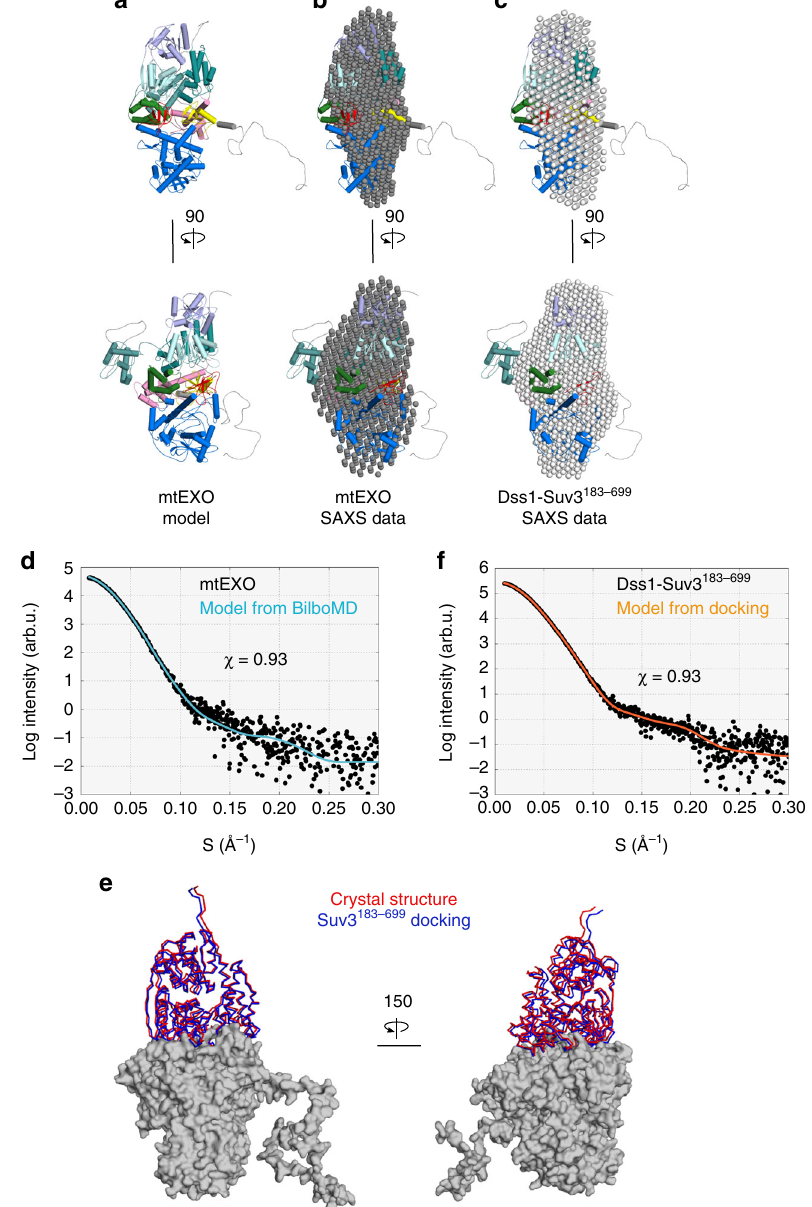
Fig. 3 Small-angle X-ray scattering experiments for Cg -mtEXO. a Model of full-length ( fl ) Cg- mtEXO calculated using Bilbo. b Model of fl - Cg- mtEXO with superimposed three-dimensional reconstruction from SAXS data for fl - Cg -mtEXO (gray spheres). c Model of fl - Cg- mtEXO with superimposed three- dimensional reconstruction from SAXS data for Cg- Dss1-Suv3 183-699 (gray spheres). d Comparison of the computed X-ray scattering curve for fl - Cg - mtEXO model shown in a (cyan) with the scattering data collected for fl - Cg -mtEXO (black circles). e The best model obtained from docking Cg -Suv3 183-699 to Cg- Dss1 using FoxsDock 28 . Cg- Dss1 is shown in gray surface representation. The Suv3 subunit from the Cg- mtEXO crystal structure is shown as a red wire. The position of Cg- Suv3 in the best-scored model is shown as a blue wire. f Comparison of the computed scattering curve for the model from docking shown in e (orange) with the SAXS data for Cg- Dss1-Suv3 183 – 699 (black protein-protected RNA length in the mtEXO channel would be 6 nt RNA fragment is also bound in the structure of human SUV3 ~18 nt. with the fi rst nucleotide exposed to the solvent 7 . The RNA is bound by residues from the helicase motifs: Ia (Lys234), Ib (Thr275) of the RecA1 domain and IV (Phe373 and Lys375), V (Thr424 and Asp425) of the RecA2 domain 7 . These motifs are conserved in Cg -Suv3 and we assume they will contact RNA in the same way. Upon superposition of Cg -mtEXO and Hs - SUV3 structures (Fig. 2d), the distance from the 3 ′ end of the SUV3-bound RNA to the 5 ′ end of the Dss1-bound RNA is 41 Å, corresponding to ~7 nt of fully stretched RNA. Therefore, the